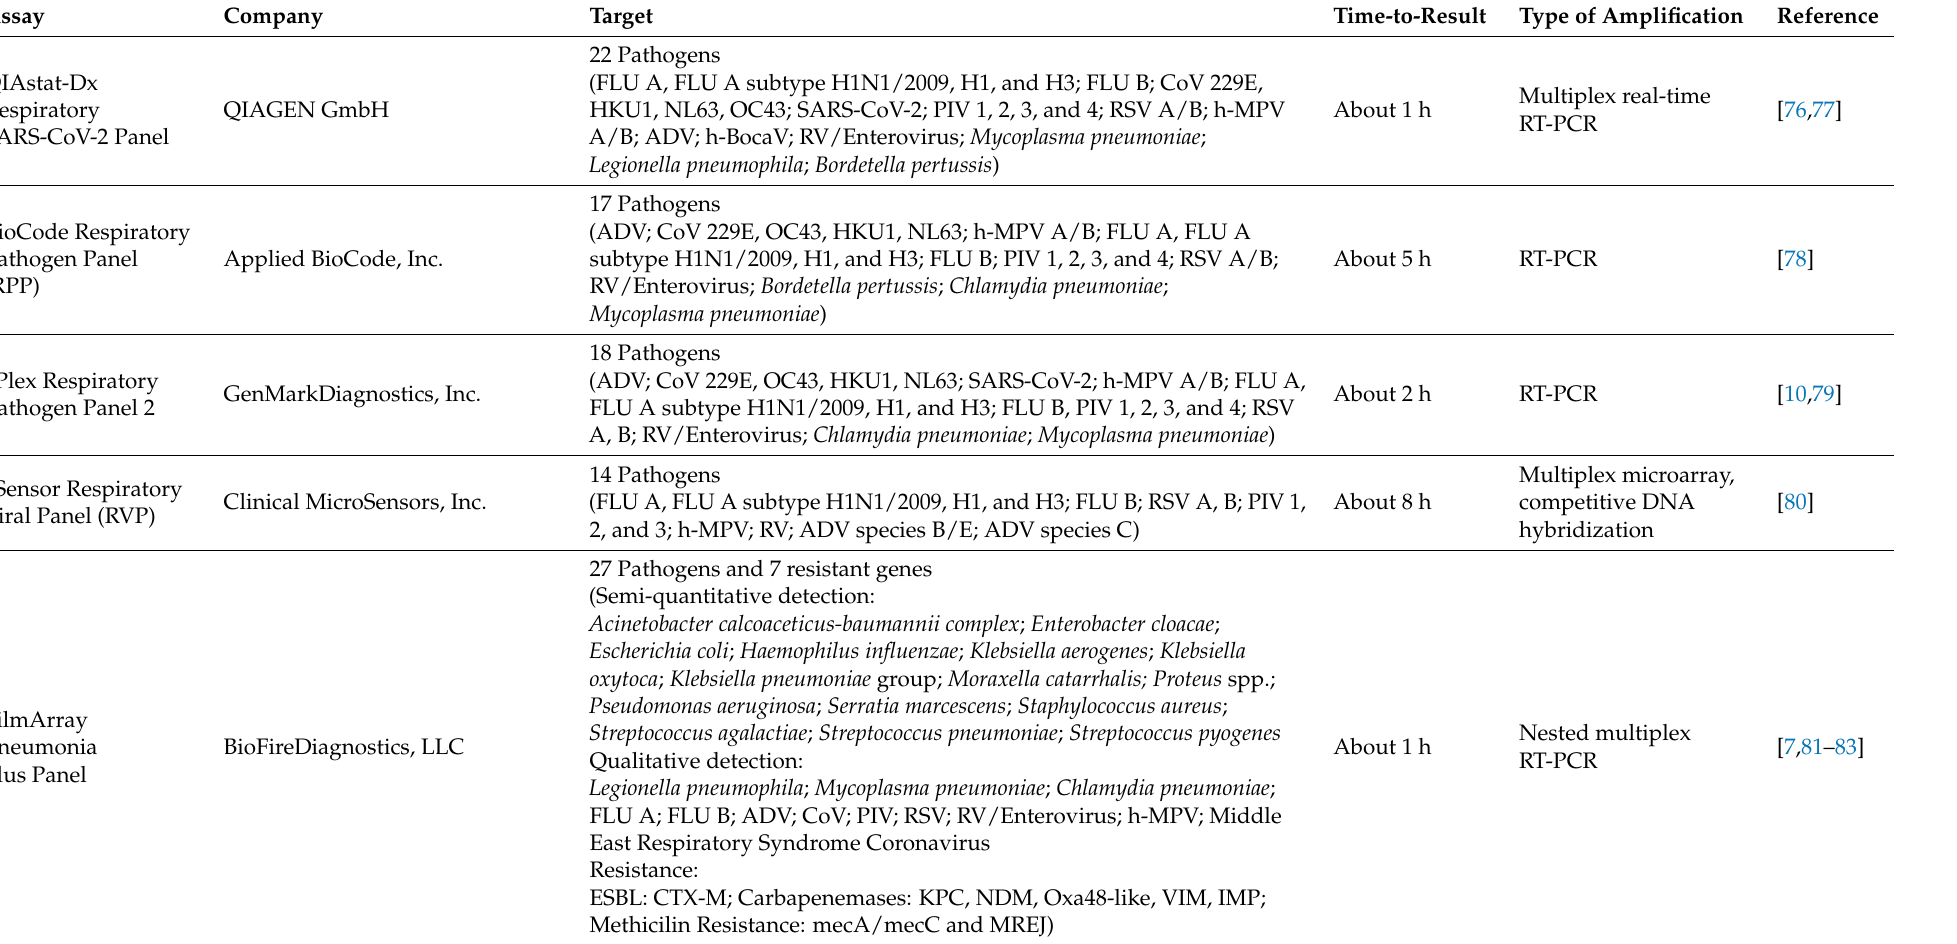
Table 2. The most relevant FDA-approved syndromic panels for the diagnosis of respiratory illnesses for both the upper and the lower respiratory